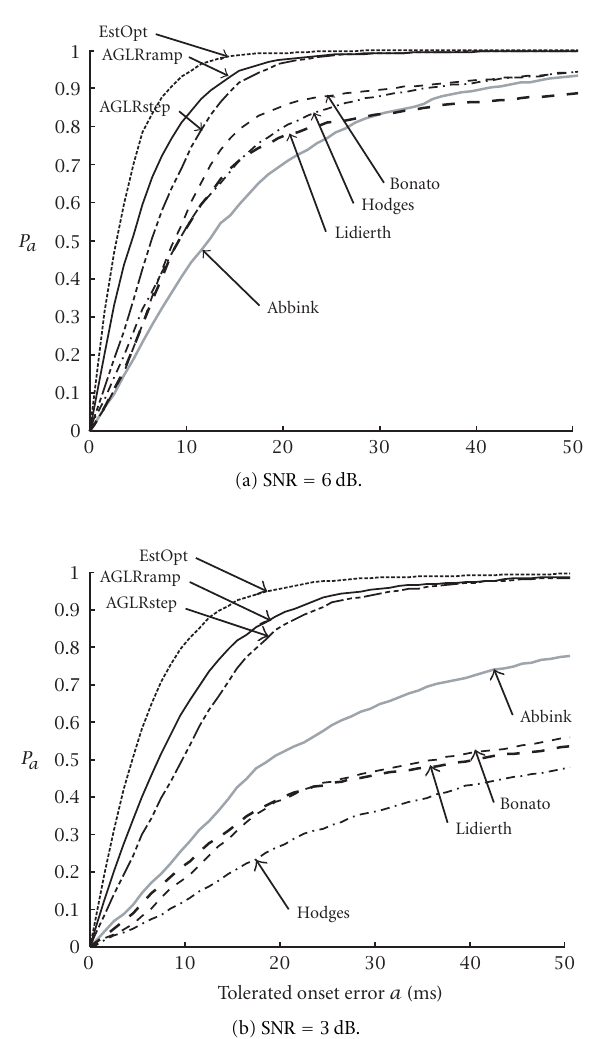
Figure 6: Dependence of accuracy functions on SNR for constant ramp duration of 20ms.